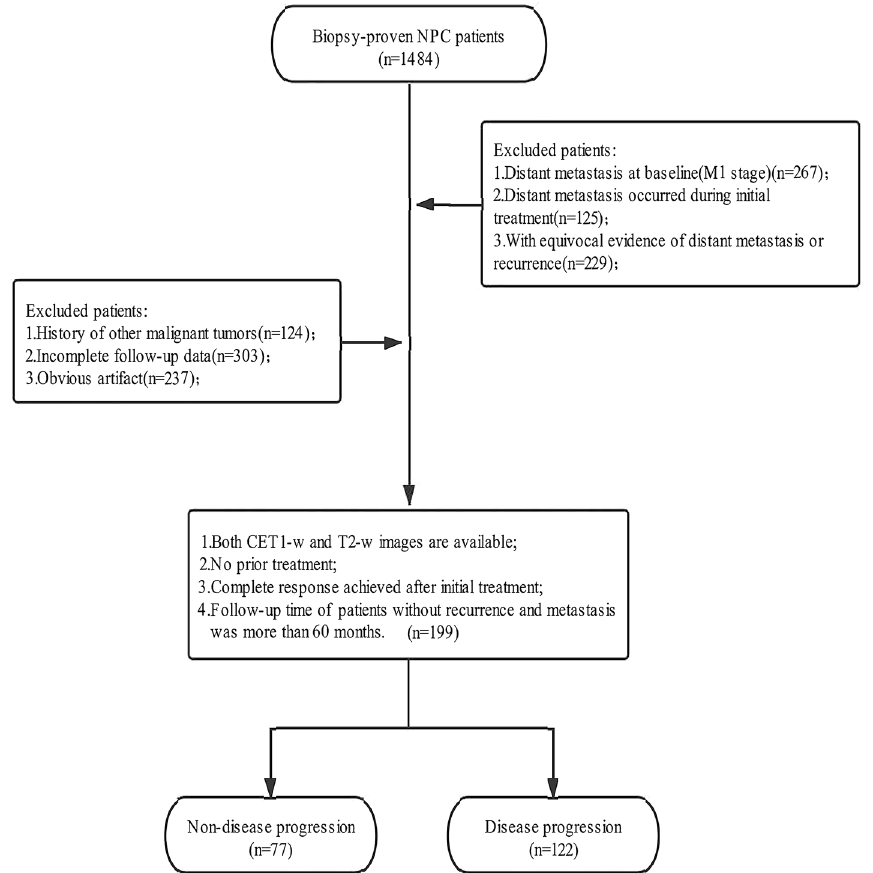
Fig. 1 Flowchart of included pathway for